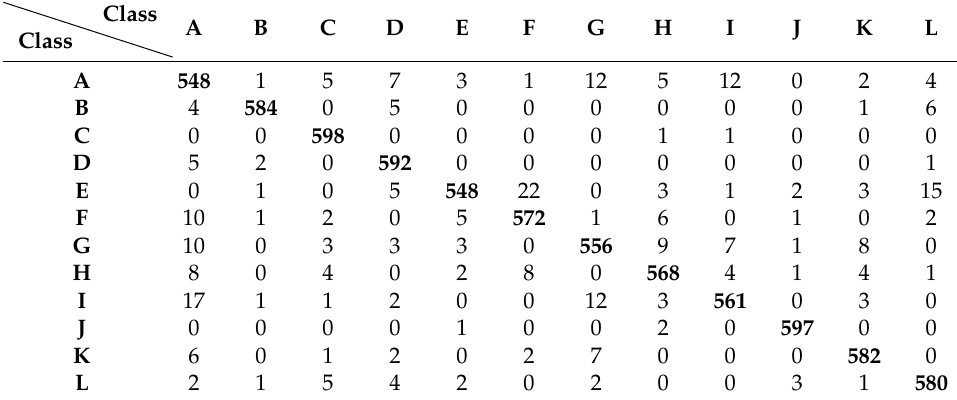
Table 13. Classification results after combination using DS theory for Elliptical, HOG and MLG features.